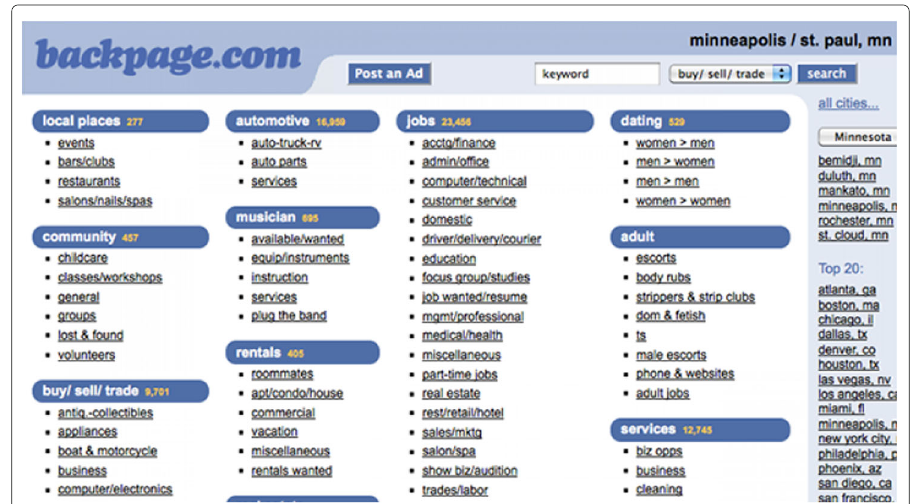
Fig. 1 The backpage.com home page, as it used to look before the entire website was shut down by federal agencies